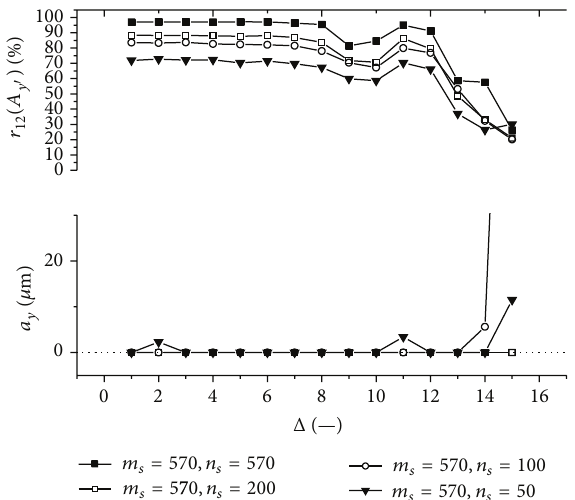
Figure 16: The evaluated object’s translation component 𝑎 𝑦 as well as the maximum 𝑟 12 (𝐴 𝑦 󸀠 ) of the 1D normalized cross-correlation function of intensity signals 𝐼 1 and 𝐼 2 acquired from decimated 2D intensity signals of various size as a function of the factor Δ . Mean speckle sizes are 𝛼 𝑥 󸀠 = 264.9 𝜇 m and 𝛼 𝑦 󸀠 = 225.5 𝜇 m. The object is translated by 𝑎 𝑥 = 100 𝜇 m and 𝑎 𝑦 = 0 𝜇 m.